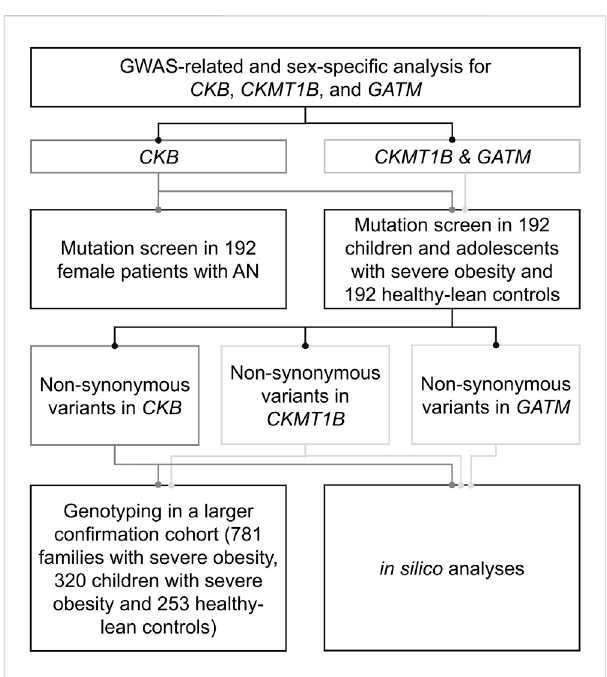
Experimental procedure of the genetic study. The genetic study comprised sex-speci fi c analyses for CKB , CKMT1B and GATM as well as a mutation screen in children and adolescents with severe obesity, healthy-lean controls, and patients with anorexia nervosa. In silico analyses were used to predict the functional implications of the detected